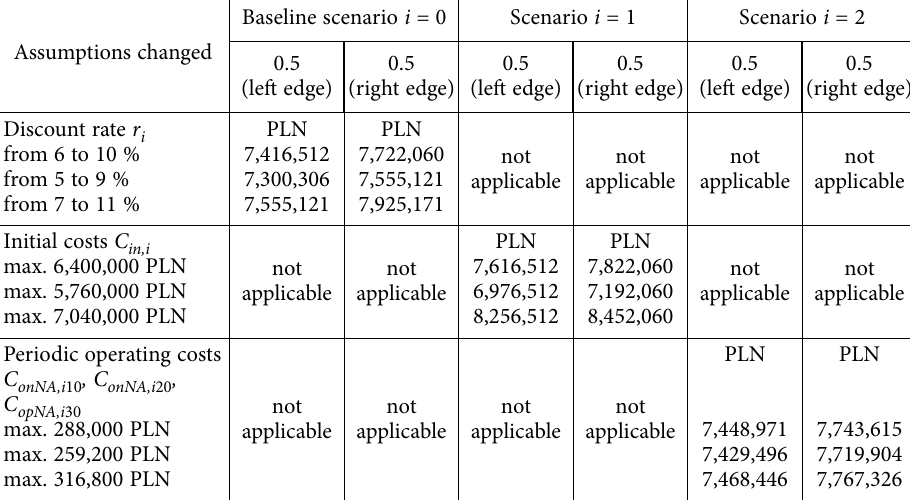
Table 9. Results of sensitivity study for the LCC i values in the section α =